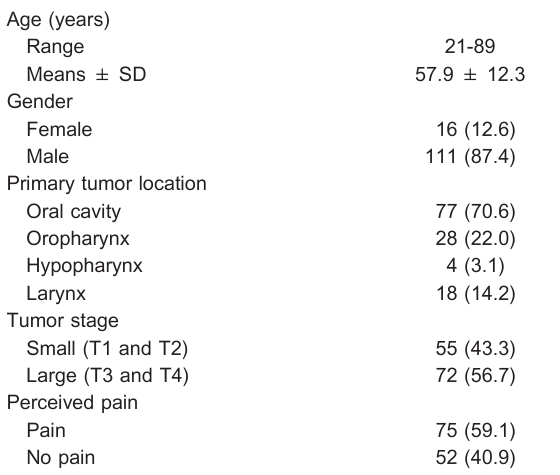
Table 1. Clinical and epidemiological